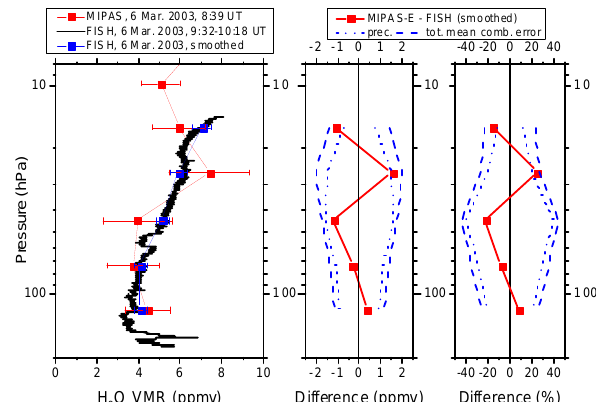
Fig. 5. Direct comparison of H 2 O profiles measured by MIPAS-E and the balloon-borne in-situ instrument FISH on 6 March 2003 at Kiruna (~68°N) along with absolute and relative differences and combined errors. The in-situ FISH profile was smoothed with the averaging kernel of MIPAS-E to make the vertical resolution of both instruments comparable. Annotation as per Fig. 4.